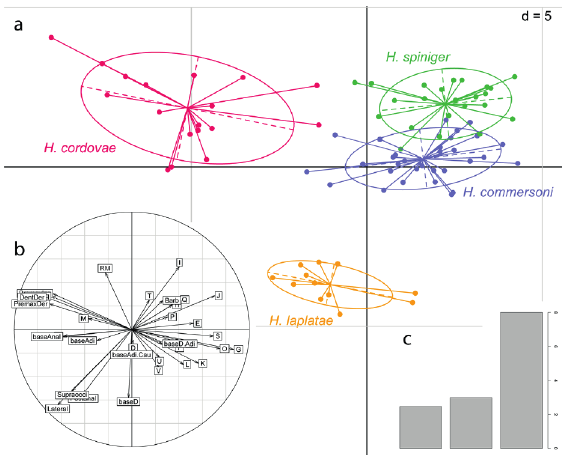
Figure 3 - Between-class Analysis (BCA) of morphological data of H. laplatae , H. cordovae , H. commersoni and H. spiniger . a . Projection of individuals’s scores onto first factorial plane of BCA, axis 1 horizontal and axis 2 vertical; b , Correlation of the variables labelled as in Tables I and II; c , eigenvalues.